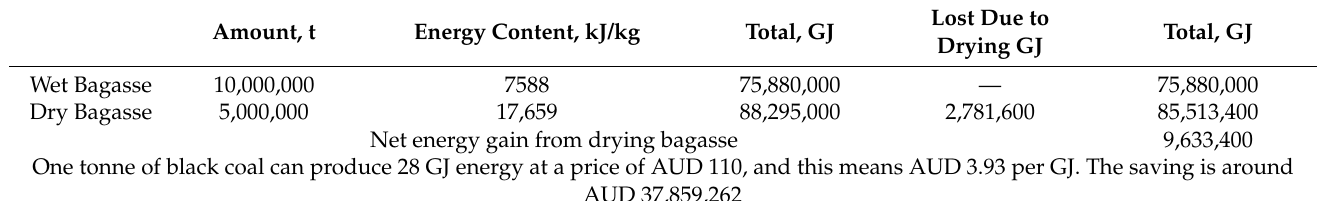
Table 24. Net energy difference between wet and dry bagasse.